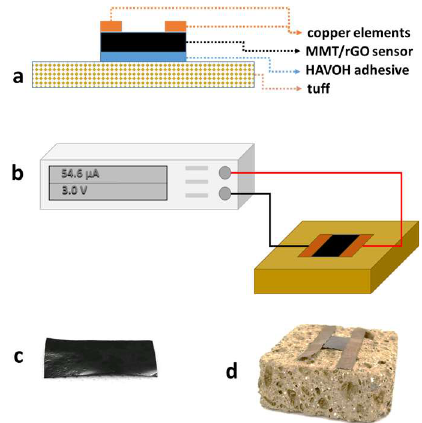
Figure 1. ( a ) Scheme of the MMT/rGO sensor applied onto the tuff specimen through the HAVOH adhesive layer; ( b ) scheme of experimental set-up used to evaluate the electrical response of the MMT/rGO sensor on the tuff specimens during the water capillary absorption test and the drying index test; ( c ) image of the MMT/rGO film; ( d ) image of the MMT/rGO sensor installed on a tuff specimen.